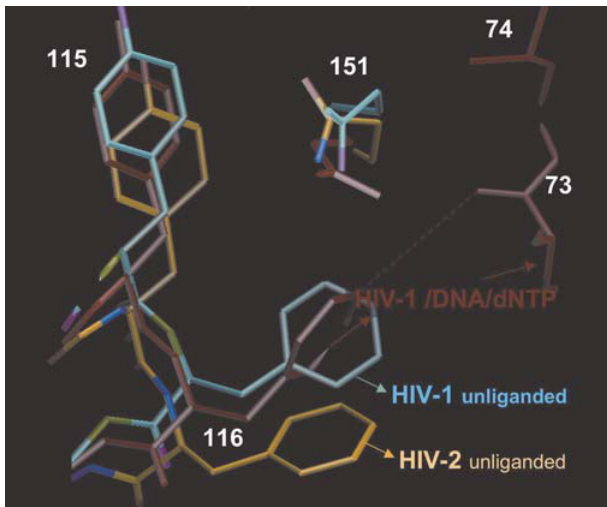
Figure 8. Superposition of HIV-1 RT and HIV-2 RT Showing the Possible Effects of a Phe116Tyr Mutation Unliganded HIV-2 RT (PDB code 1MU2) is shown in yellow, unliganded HIV-1RT (PDB code 1DLO) is shown in cyan, and HIV-1 RT/DNA/dTTP (PDB code 1RTD) is shown in red. The superposition shows that a Phe116Tyr mutation in HIV-1 RT would affect the interactions of position 116 with the main-chain carbonyl of Lys73 in the fingers subdomain of HIV-1 RT (dotted line). However, the same mutation in HIV-2 RT is not likely to cause similar interactions of Tyr116 with the fingers subdomain of HIV-2 because the differences in the position of the small helix that carries residues 115–117 in HIV-2 RT make the interaction unlikely. DOI: